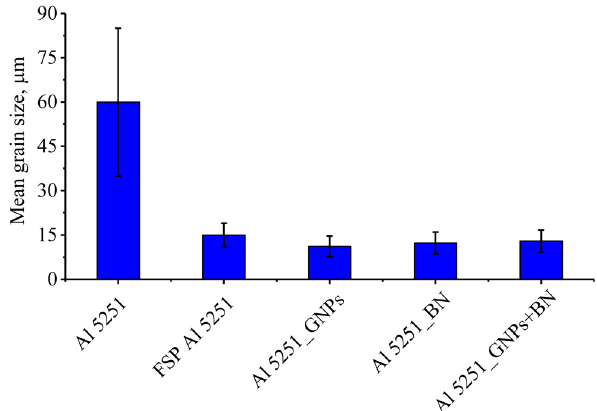
Figure 5: Average grain size of the as - received BM and friction SZ without and with di ff erent reinforcements